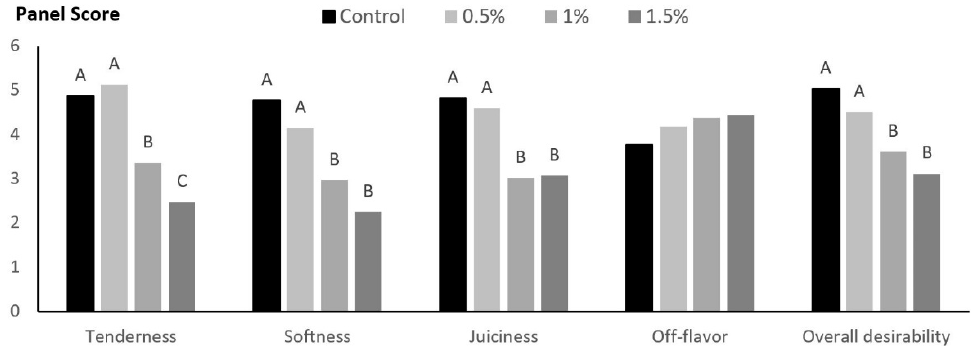
Figure 2. Sensory attributes of beef patties formulated with different levels of TE (Control = 0%, 0.5%, 1%, and 1.5%). Tenderness p < 0.0001, SEM = 0.10; softness p < 0.0001, SEM = 0.11; juiciness p < 0.0001, SEM = 0.12; off-flavor p = 0.353, SEM = 0.13; and overall desirability p < 0.0001, SEM = 0.11. A,B,C Means with different superscripts are significantly different within tannin extract levels.